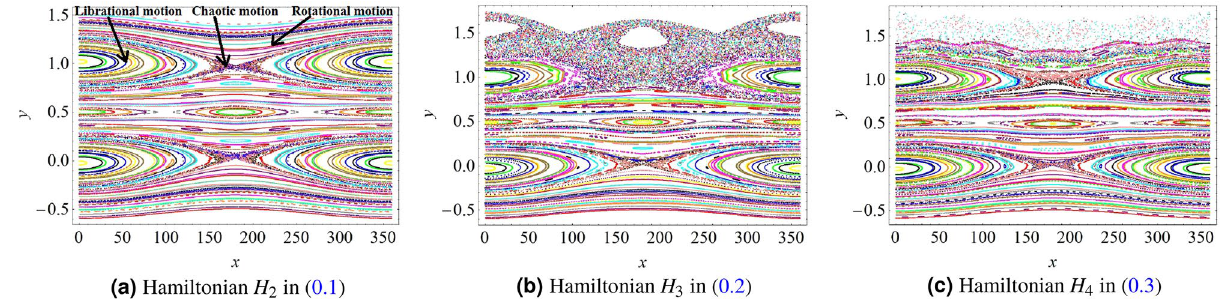
Figure 1. Poincaré maps associated to Hamiltonians (1), (2) and (3) for ε = 0.02 , 5 × 10 5 iterations and a time step equal to h = 2 π 10 3